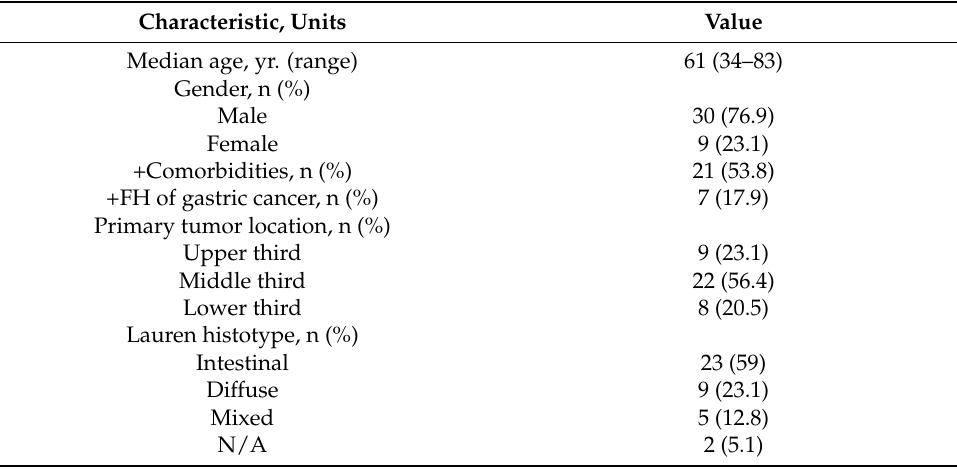
Table 1. Basic clinical characteristics of patients of the study (n =